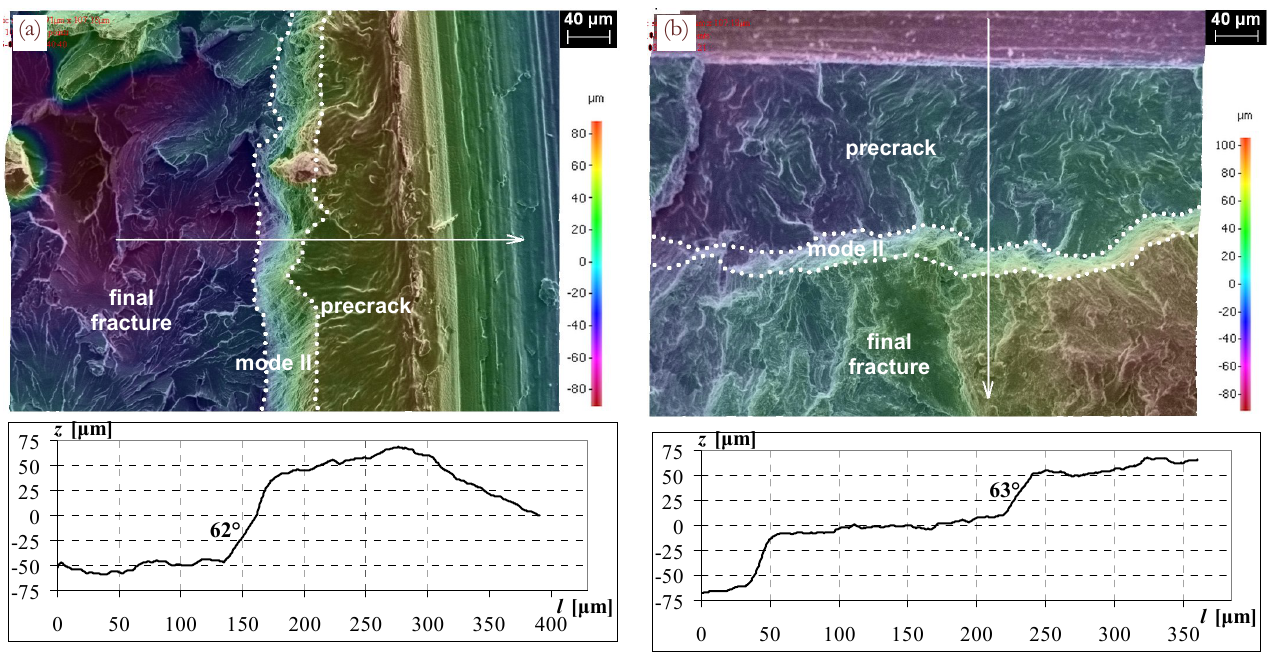
Figure 4: Mode II in pearlitic steel, cylindrical shear specimen (a), compact-tension shear specimen (b). The white arrow defines the profile showed below and is parallel to the applied shear direction.